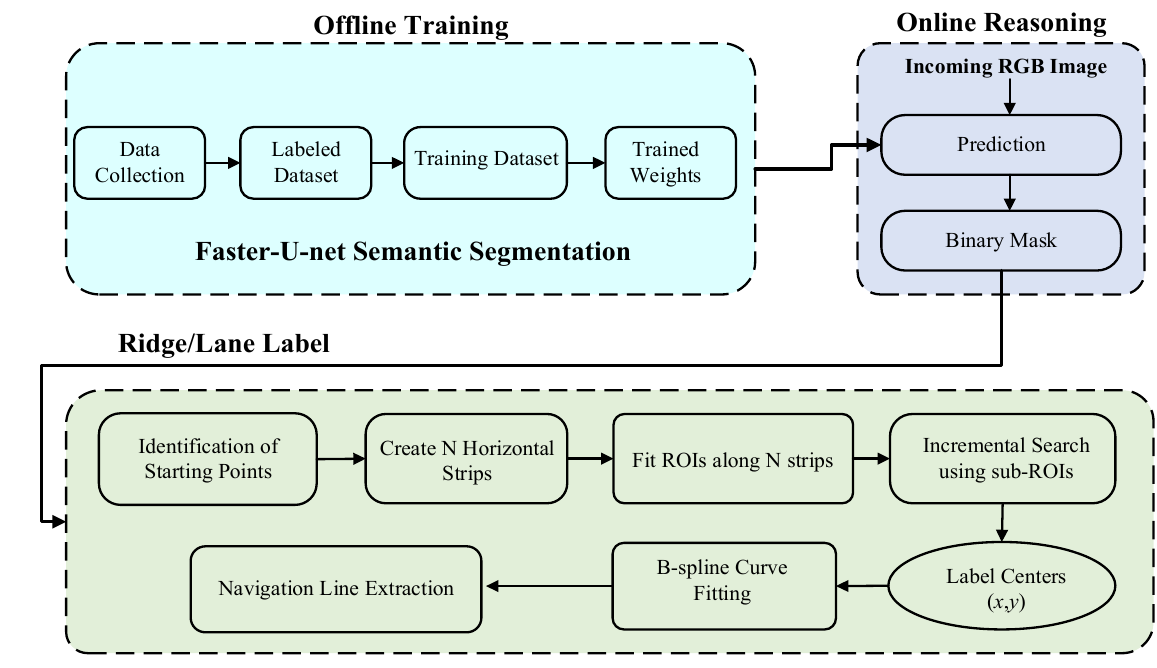
Figure 2. Pipeline for the proposed adaptive multi-ROI-based image semantic segmentation is presented as three subparts: offline training involved data collection and training the dataset, offline reasoning made a prediction over an incoming RGB image, and navigation line extraction applied the fitting procedure over the predicted mask with the proposed adaptive multi-ROI method.